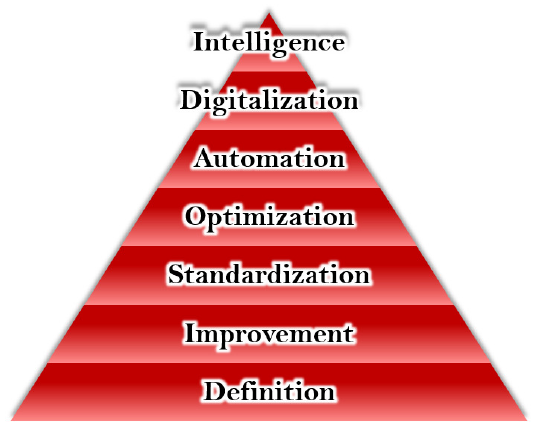
Figure 4. Maturity echelons of the process system